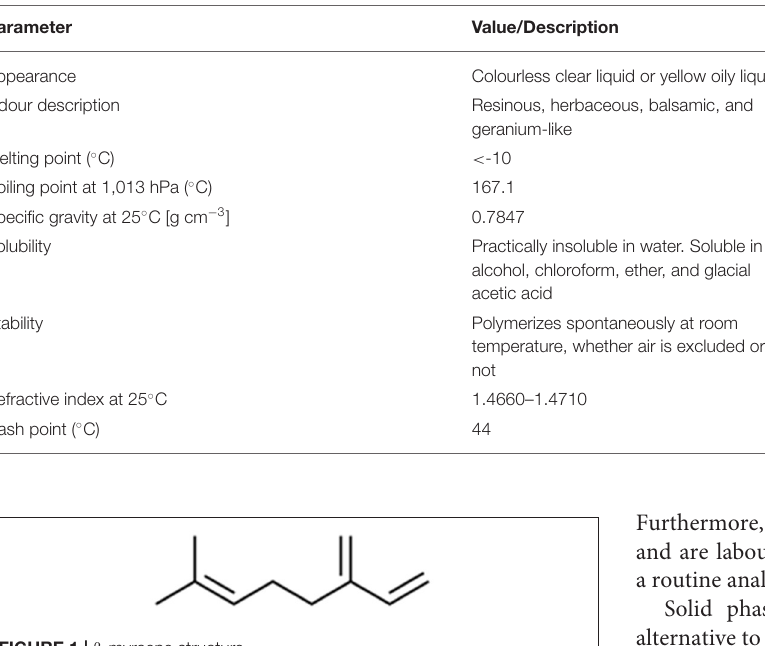
FIGURE 1 | β -myrcene